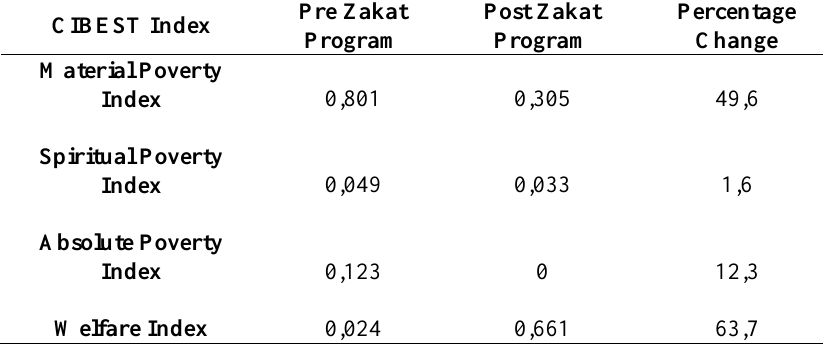
Table 4 CIBEST Index: Pre and Post Zakat